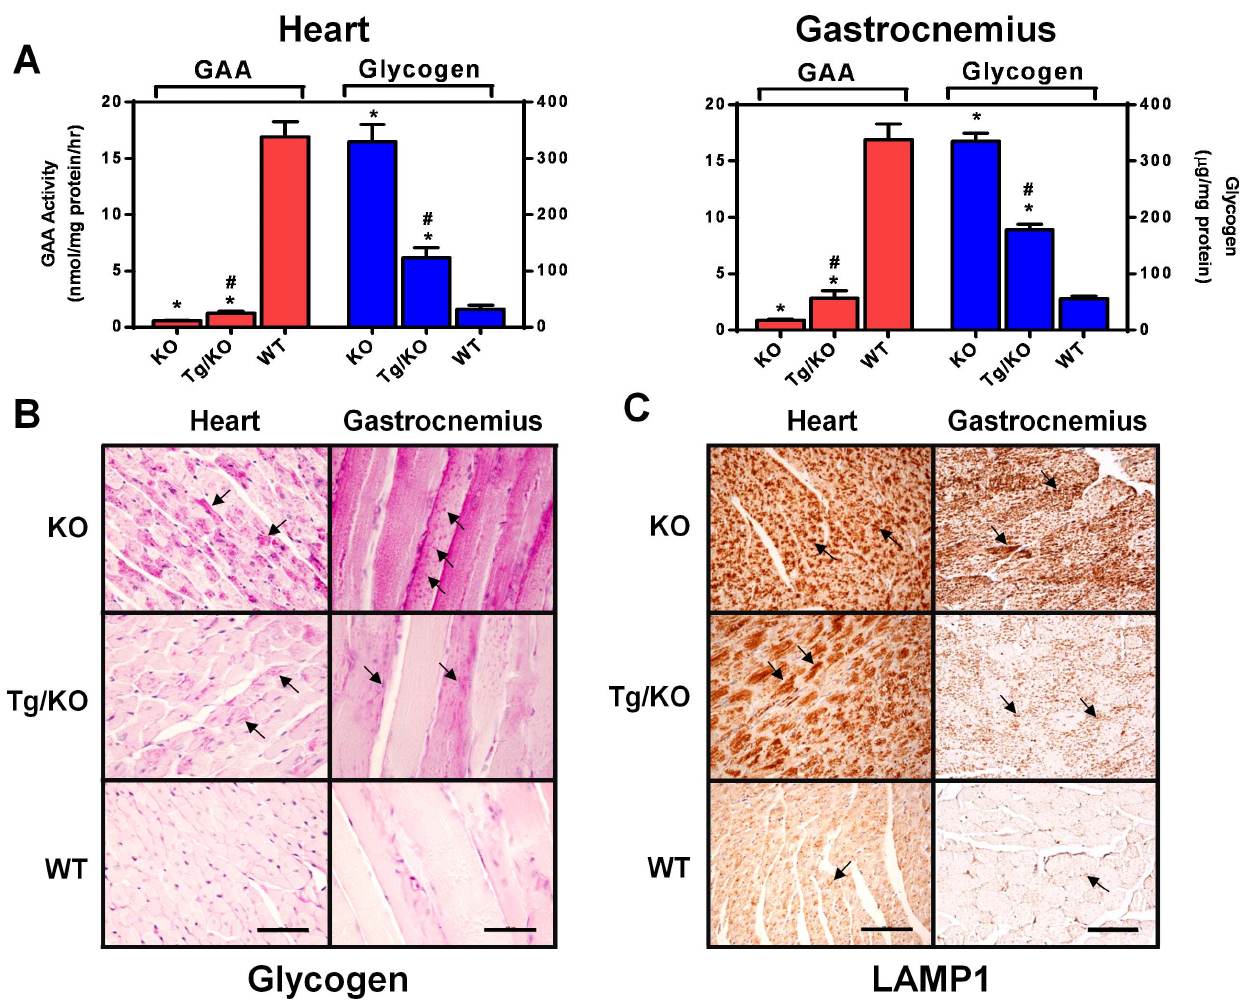
Figure 5. hP545L GAA Tg/KO mice have reduced tissue GAA activity, and elevated glycogen and LAMP1 levels. ( A ) GAA and glycogen levels were assessed in tissue lysates prepared from heart and gastrocnemius of 12-week old male Gaa KO, hP545L GAA Tg/KO, and wild-type (denoted as ‘WT’ in the figure) mice. Significant differences in GAA activity and glycogen levels in hP545L GAA Tg/KO and Gaa KO mice compared to wild-type mice are reported as *p , 0.05, t-test. Significant differences in GAA activity and glycogen levels in hP545L GAA Tg/KO mice compared to Gaa KO mice are reported as # p , 0.05, t-test. Each bar represents the mean 6 SEM from four mice per group analyzed in triplicate. Glycogen accumulation ( B ) and lysosomal proliferation (assessed by the quantity of LAMP1) ( C ) were assessed histochemically in Gaa KO, hP545L GAA Tg/KO, and wild-type (denoted as ‘WT’ in the figure) mouse cardiomyocytes and skeletal muscles fibers of the gastrocnemius. Glycogen staining is represented as dark pink spots, and LAMP1 staining as dark brown spots (each denoted with black arrows). The data shown are representative photomicrographs from four mice using a 40 6 (scale bar: 50 m m) or 20 6 (scale bar: 100 m m) objective in ( B ) and ( C ), respectively.